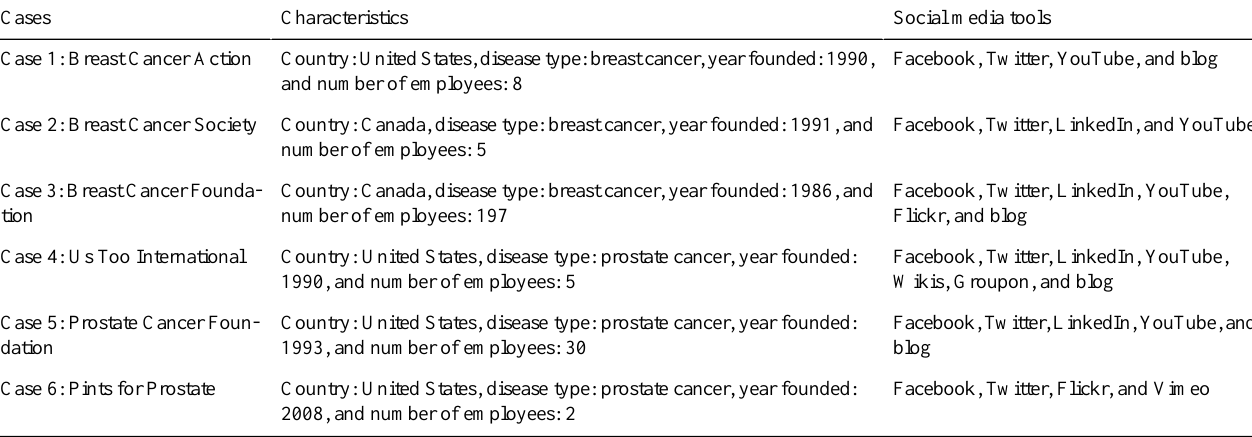
Table 1. Case characteristics and social media tools used.